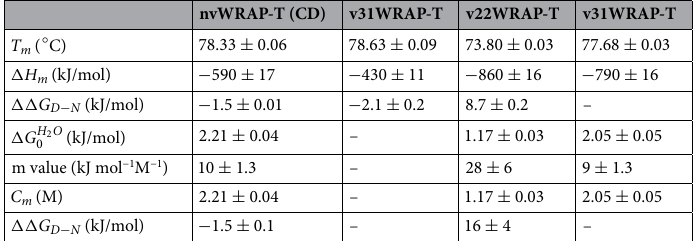
Table 2. Stability parameters of the